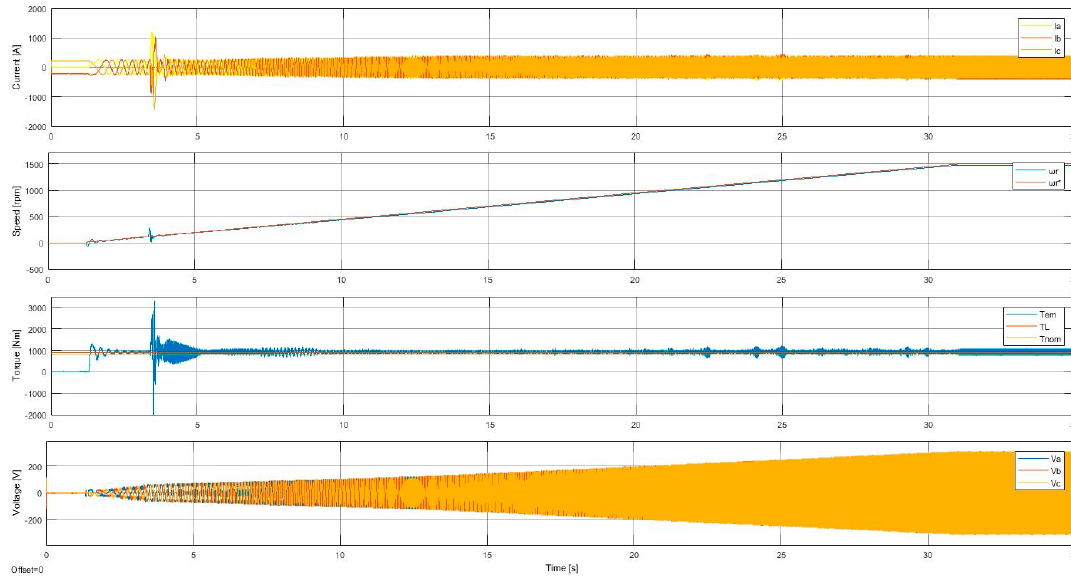
Figure 5. Real-time simulation results of the proposed adaptive HST-SCS for a 200 HP IM.